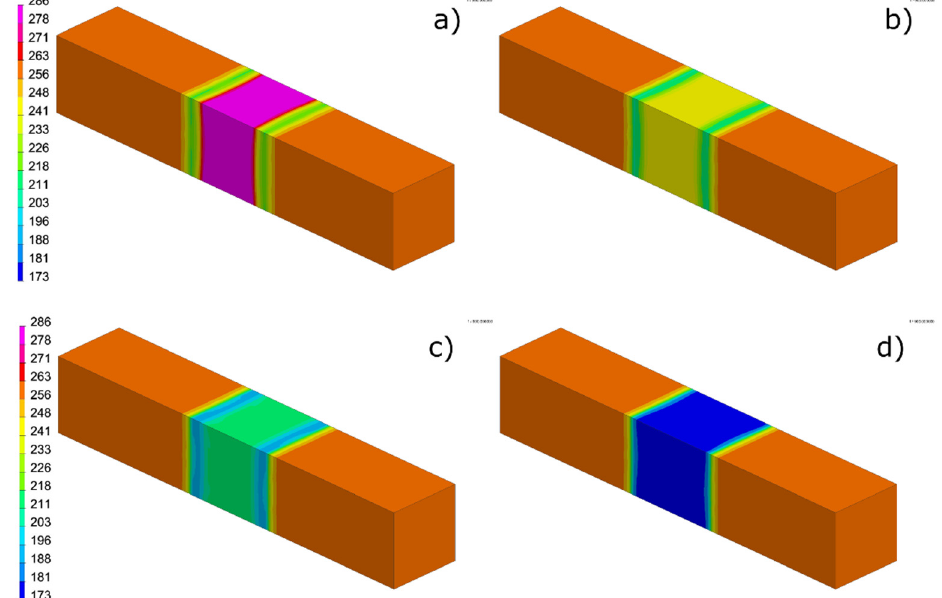
Figure 18. The results of numerical analyses of HAZ hardness distributions of selected S700MC steel samples heated with the thermal cycle with a maximum temperature about 1250 °C and cooling times